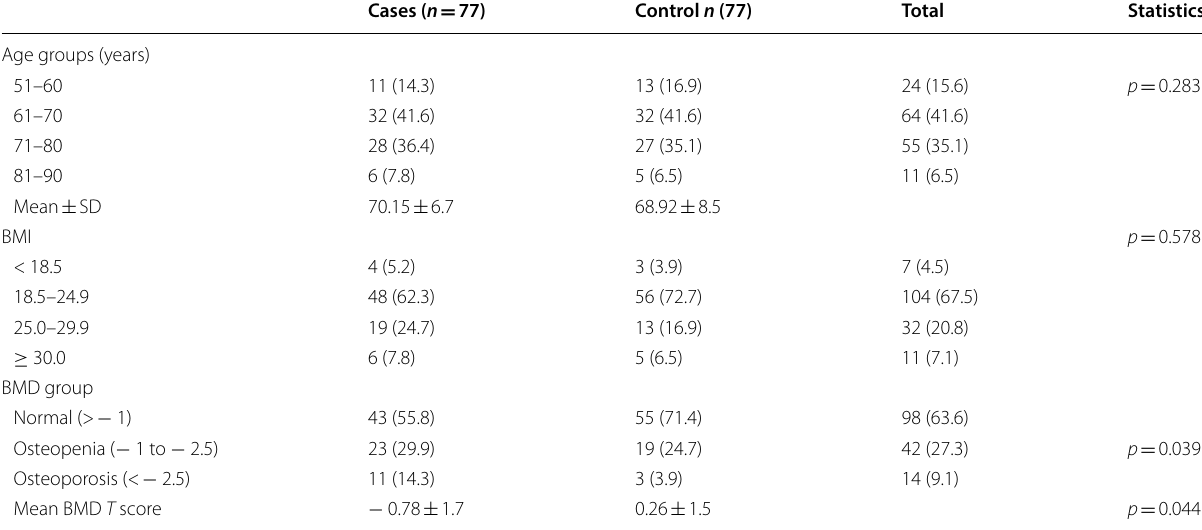
Table 1 Patients characteristics, Gleason score, BMD categories of case and control groups, the mean BMD, decreasing trend of BMD pre- and